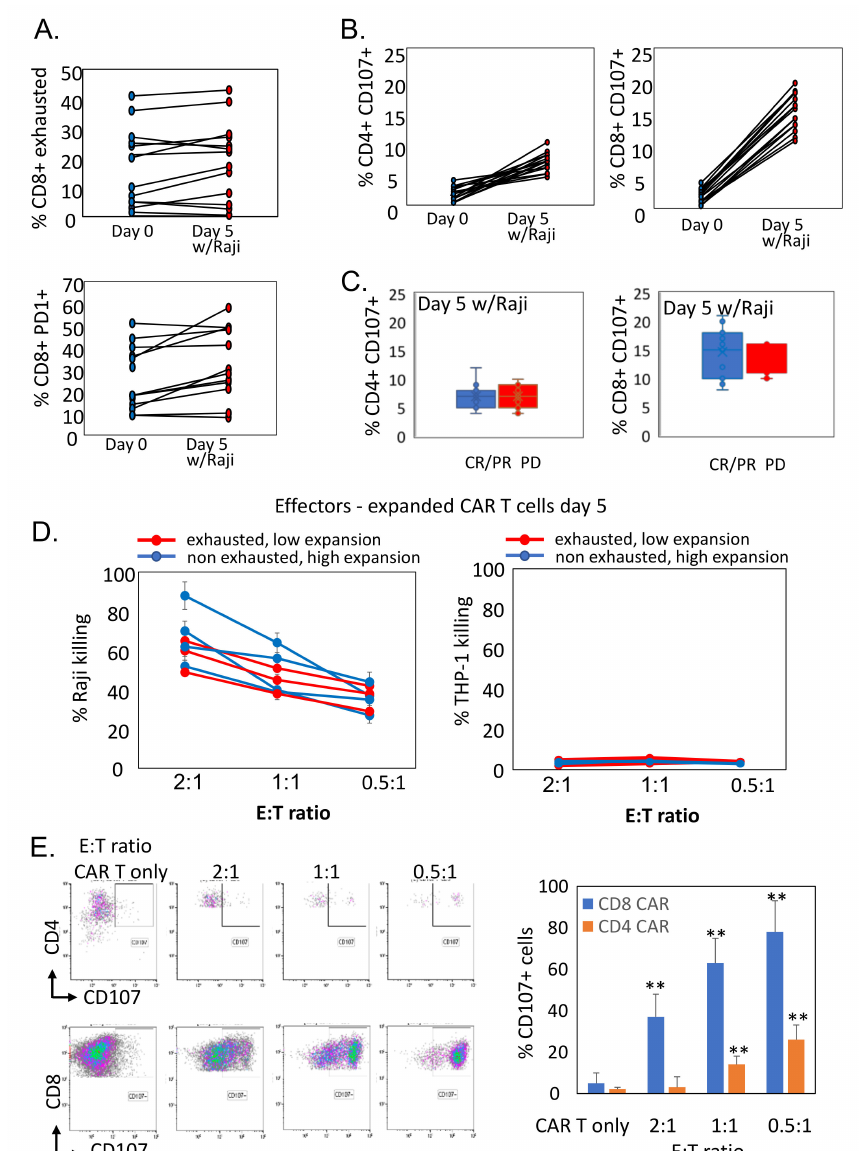
Figure 5. Antigen exposed CAR T cells preserve anti-tumor activity. ( A ) Frequency of exhausted and PD1-expressing CD8 + cells in paired samples of pre-infused CAR T cell products and expanded CAR T cells ( n = 22) after 5 days of co-culture with Raji cells. ( B ) Frequency of degranulated CD107-expressing CD4 + and CD8 + cells in paired samples of pre-infused CAR T cell products and expanded CAR T cells ( n = 22) after 5 days of co-culture with Raji cells; ** p < 0.01. ( C ) Percentages of degranulated CD107 + CD8 + and CD4 + T cells in antigen-exposed CAR T cells from patients in each response group (CR/PR, n = 12; PD, n = 10). ( D ) Percentage of specific lysis induced by antigen-exposed CAR-T cells against CFSE-labeled target tumor cells (Raji and THP-1) at indicated E:T ratios determined by FACS analysis at 4h culture. Experiments were performed with three biological replicates. Data are presented as mean ± SD (** p < 0.01, two-sided Student’s t -test). CAR T cells with exhausted phenotype and low expansion rate (below 2.5-fold at day 5) are depicted in red ( n = 4). CAR T cells with non-exhausted phenotype and high expansion rate (above 3-fold at day 5) are depicted in blue ( n = 3). ( E ) Frequency of degranulation (CD107 expression) in expanded CD8 + and CD4 + CAR T cells that were repeatedly stimulated with CFSE-labeled Raji cells at indicated E:T ratios determined by FACS analysis at 4h culture. Left panel—representative dop plots, right panel—summarized data presented as mean ± SD (** p < 0.01, two-sided Student’s t